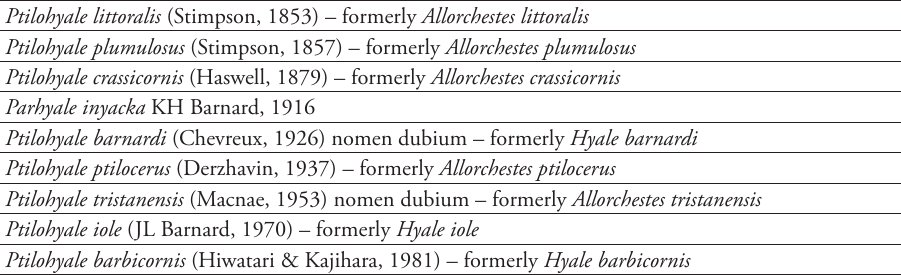
Table 1. List of Parhyale and Ptilohyale species excluded by Barnard’s taxonomy key (Barnard 1979: 120) and by Arresti (1989), here named according to Lowry (2010) and Lowry et al.